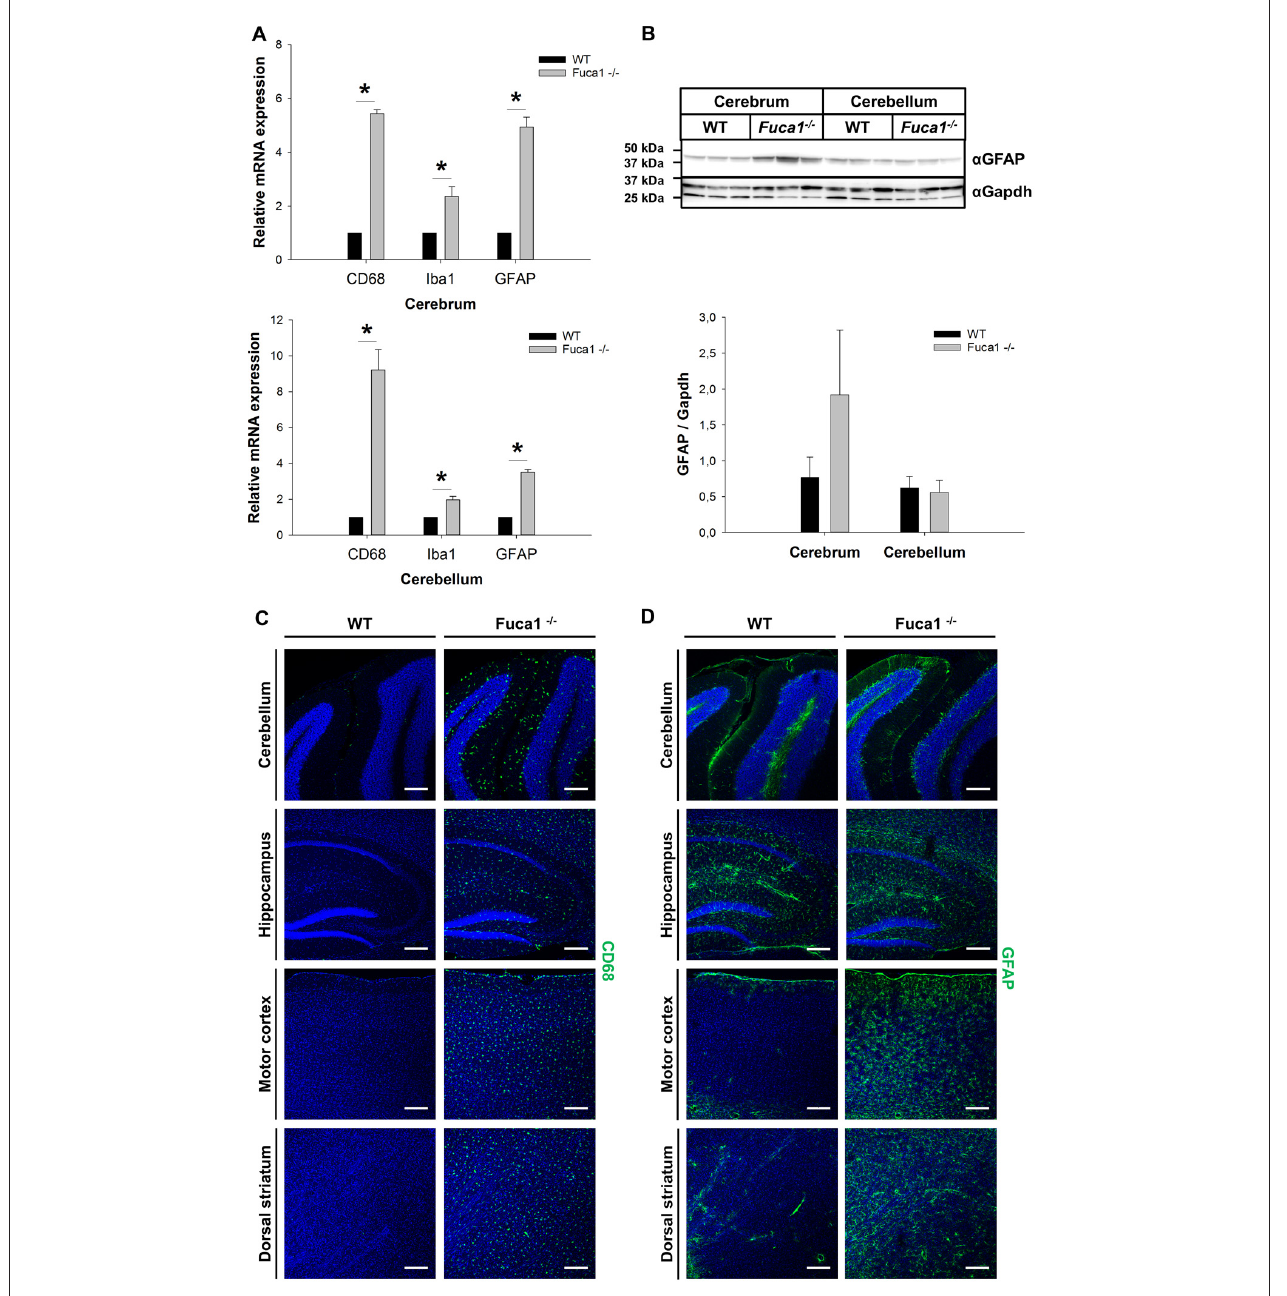
FIGURE 2 | Increased expression of neuroinflammation markers in Fuca1-deficient mouse brains. (A) Quantitative PCR analysis of mRNA cerebrum and cerebellum revealed increased transcript levels for CD68, Iba1 and GFAP in 3-month-old Fuca1-deficient mice. (B) Tissue homogenates from cerebrum and cerebellum were separated by SDS-PAGE and blotted onto PVDF membrane. After blotting, the membrane was cut and the part of the membrane representing proteins larger than 25 kDa was analyzed for GFAP. An apparent increase in GFAP protein was found in the cerebrum but not in the cerebellum of 3-month-old Fuca1-deficient mice as shown by immunoblotting of tissue homogenates (mean ± SD, n = 3), but both comparisons did not reach significance. Gapdh was used for normalization. Immunofluorescence staining showed elevated amounts of CD68 (C) and GFAP (D) in the cerebellum, hippocampus, motor cortex and the dorsal striatum of 3-month-old Fuca1-deficient mice. The cell nuclei were stained with DAPI. Scale bars = 200 µ m. Asterisk indicates significance of difference.